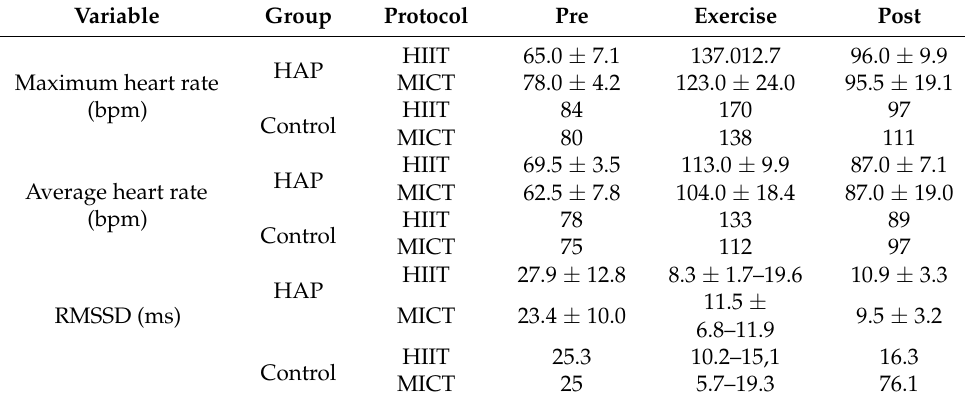
Table 3. Heart rate and heart rate variability parameters in heart attack patients (HAP) and control in high-intensity interval training (HIIT) and moderate-intensity continuous training (MICT).